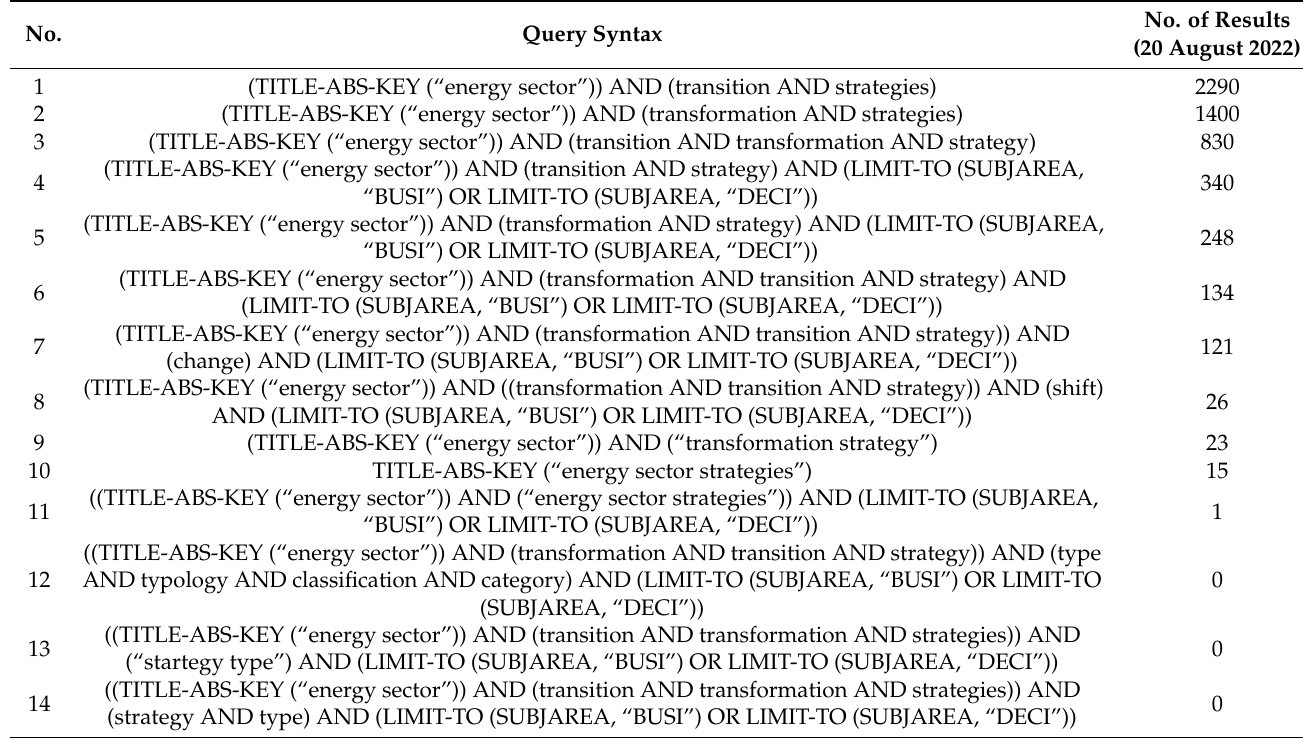
Table 1. Syntaxes used in queries calibration for the Scopus scientific database exploration.